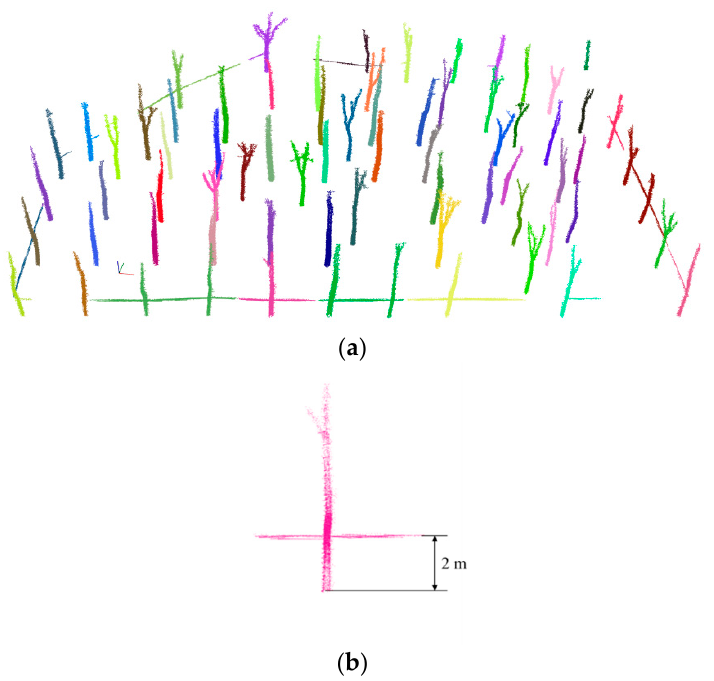
Figure 5 . Clustering and individual analysis. ( a ) Clustering results for the experimental areas; ( b ) tree number 5.